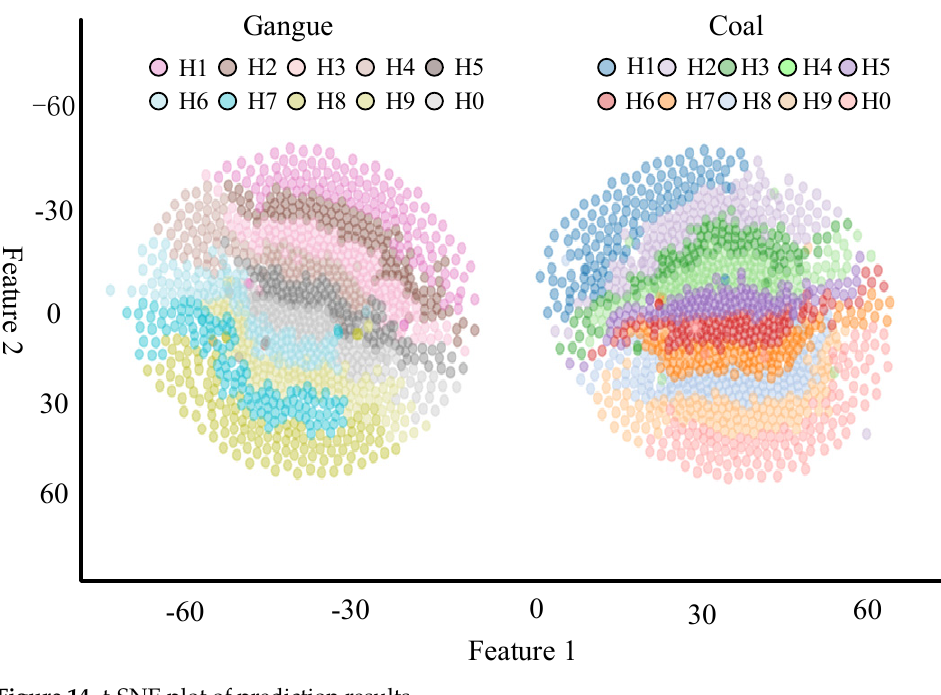
Figure 14. t-SNE plot of prediction results.